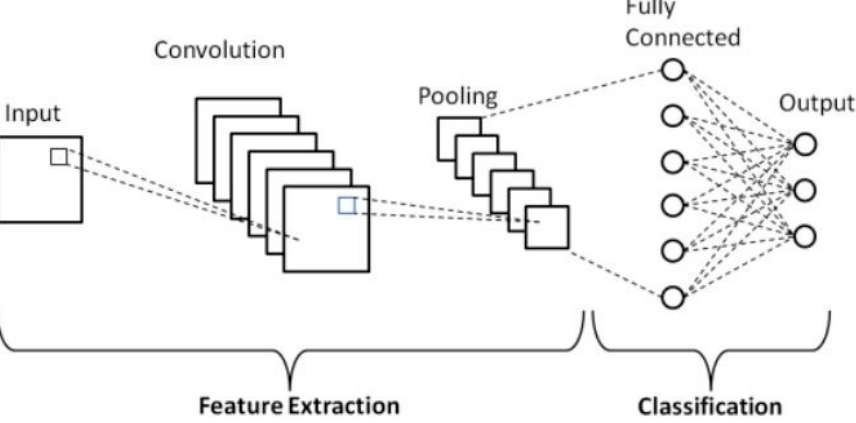
Figure 1. Schematic diagram of a basic convolutional neural network (CNN) architecture [7]. The R-CNN (Region Based Convolutional Neural Network) and faster R-CNN